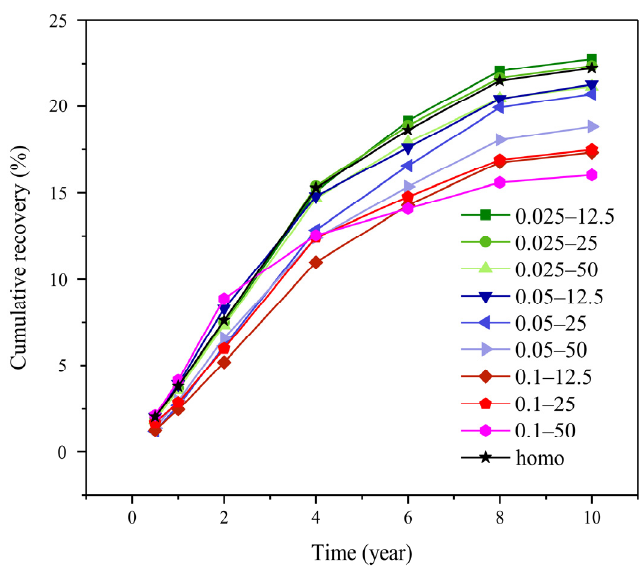
Figure 11. Cumulative recovery statistics of each case.